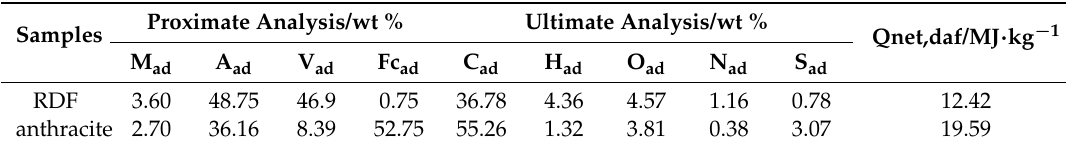
Table 1. Proximate analysis, ultimate analysis, and calorific value results.